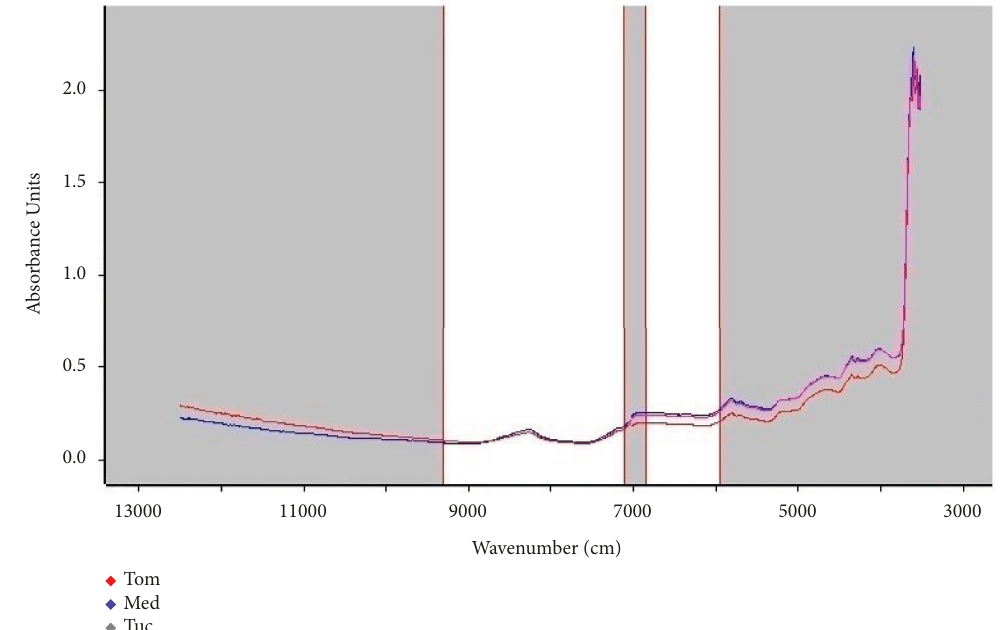
Figure 5: Absorption spectrum highlighting the two separation regions of DFD samples (1st and 2nd